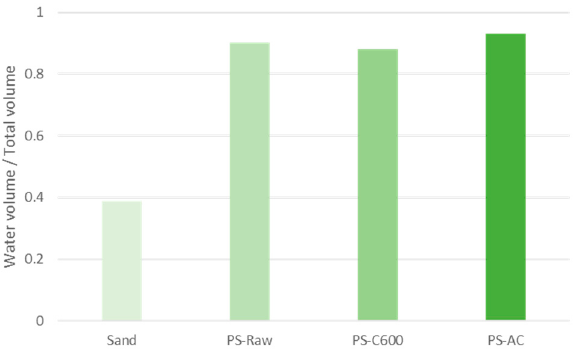
Figure 12. Water holding capacity of biomasses on volume basis.